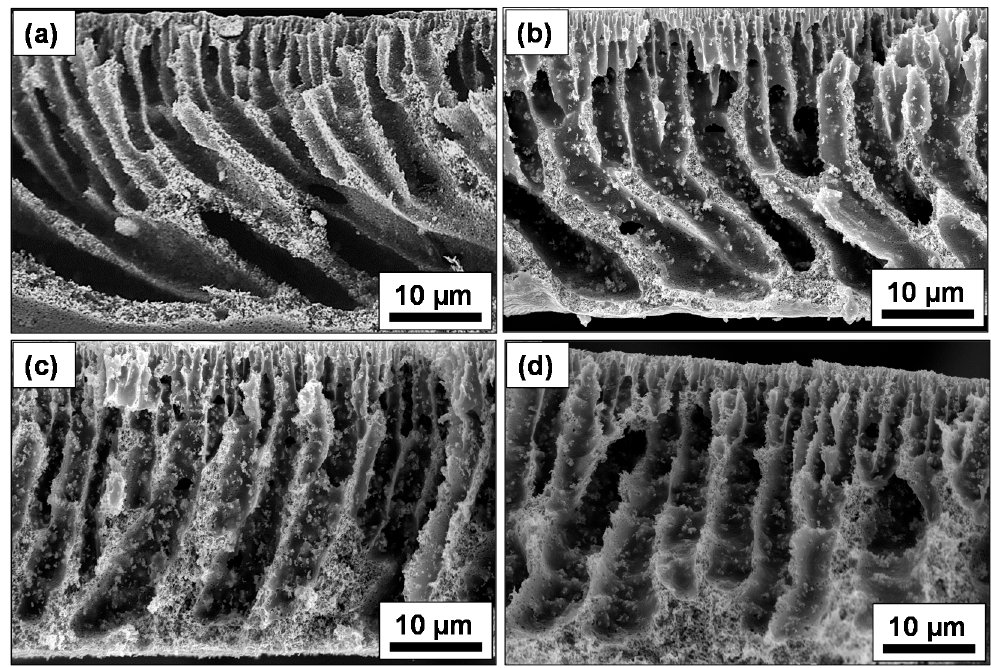
Figure 3. The cross-sectional SEM micrographs of PES/ZnO film photocatalysts with different ZnO loading, ( a ) PZ-0; ( b ) PZ-9; ( c ) PZ-17; and ( d ) PZ-19.